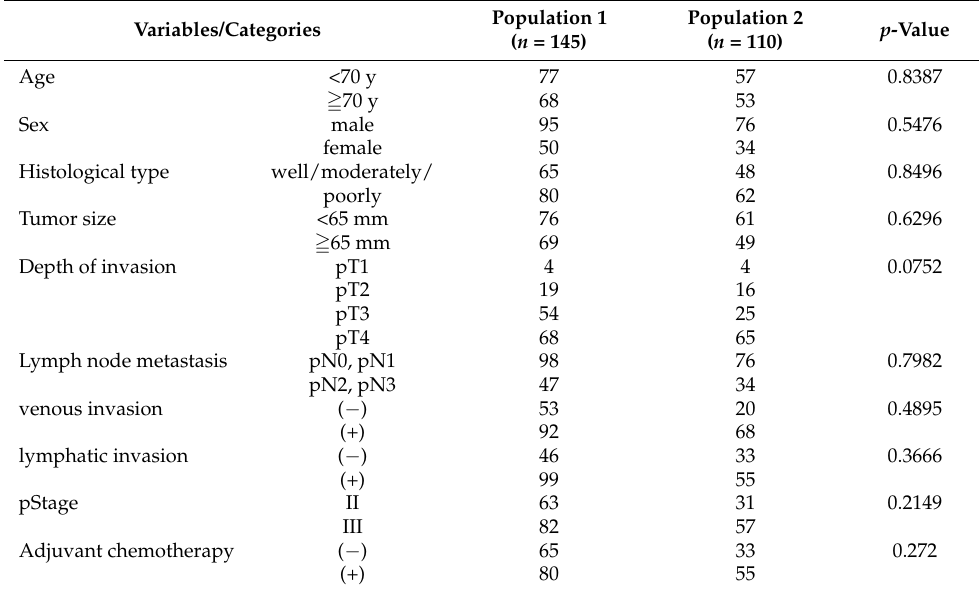
Table 1. The clinicopathological data of 255 patients with stage II/III GC in qPCR analysis.